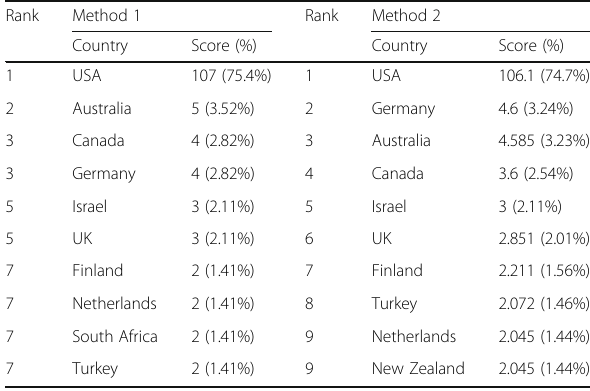
Table 2 Comparisons of authorship nationality to 142 publications using two